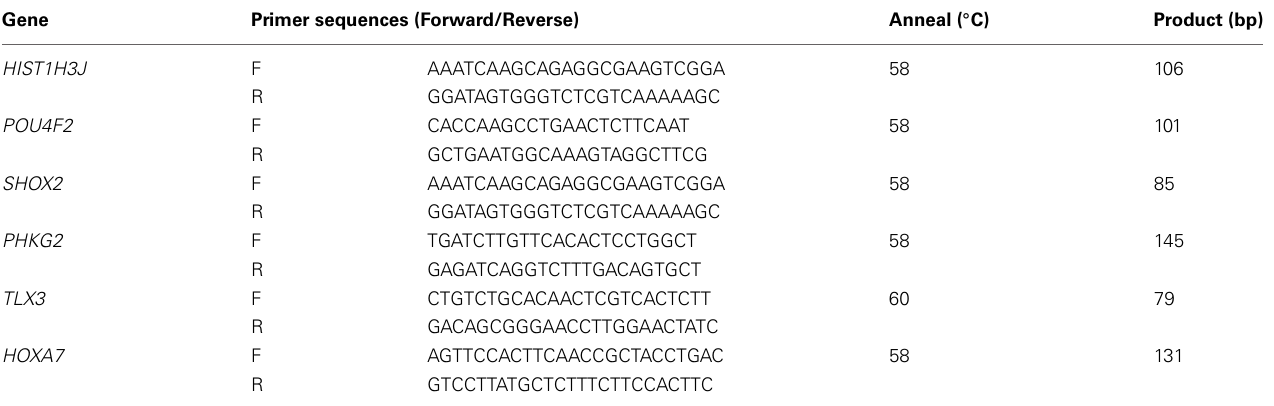
Table 3 | Primer sequences for real-time RT-PCR in gene re-expression analysis.